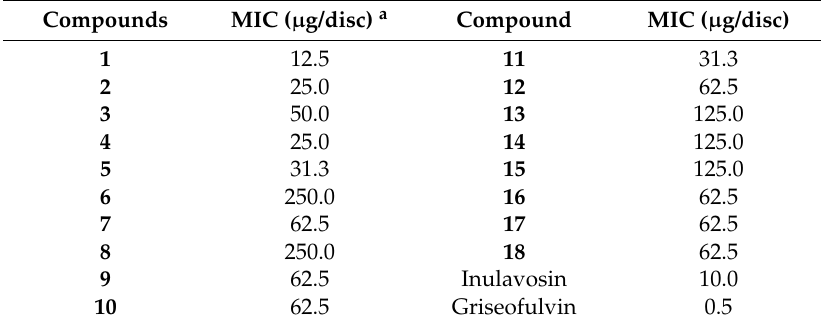
Table 1. Antifungal activity of constituents isolated from S. album against Trichophyton rubrum . Compounds MIC ( µ g/disc) a Compound MIC ( µ